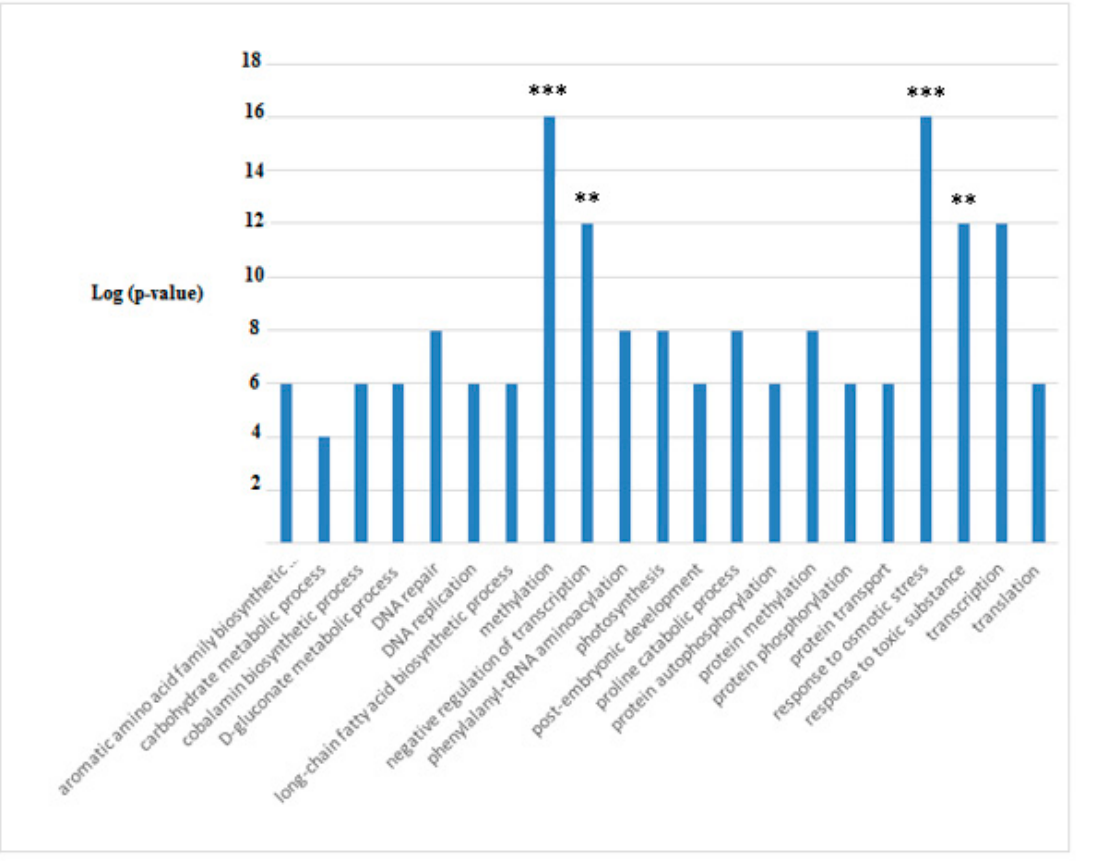
Figure 11. Functional annotation of DAPs in A. maxima samples after 21 days of treatment with 0.2 mM glyphosate; the histograms referred to the GO terms to which the enriched proteins, with statistical values of p < 0.05, belonged. The data presented are log-transformed p -values (corrected with FDR) of GO terms or KEGG (KG) pathways that were found to be enriched in the group of proteins tested. *** p < 0.0001; ** p < 0.001). The details of the analysis are reported in Supplementary Table